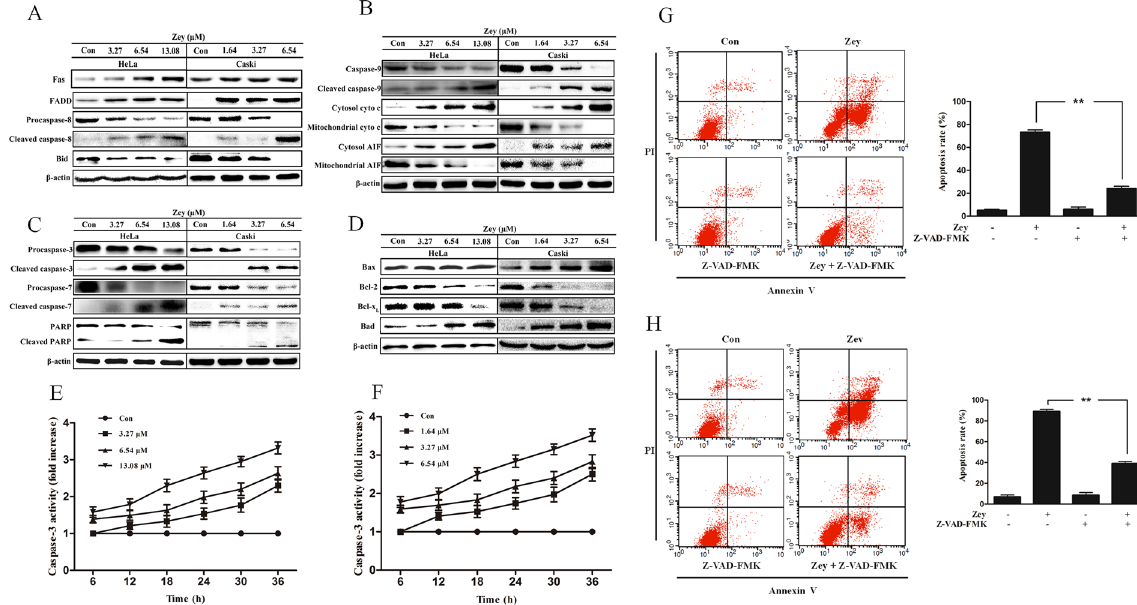
Figure 5. Zey induces apoptosis of HeLa and CaSki cells through caspase activation. ( A ) Zey induced expression changes of FAS, FADD, Bid, pro-caspase 8, and cleaved-caspase 8. ( B ) Zey induces release of AIF and cytochrome C from mitochondria and cleavage of caspase 9. HeLa and CaSki cells were treated with Zey for 24 h, then cell cytoplasm were extracted by digitonin buffer and the released AIF and cytochrome C were detected by western blot analysis. ( C ) Zey induces cleavage of PARP, caspases-3, and -7 in HeLa and CaSki cells. ( D ) Zey decreased expression of antiapoptotic proteins Bcl-XL, and Bcl-2, and increased expression of apoptotic proteins Bax and Bad. Zey inhibits caspase 3 activity of HeLa ( E ) and CaSki cells ( F ). Data were presented as the means ± SD for triplicate determinations. * P < 0.05, ** P < 0.01 versus control cells. Pan caspase inhibitor Z-VAD-FMK significantly attenuated Zey-induced apoptosis in HeLa ( G ) and CaSki cells ( H ). Data are presented as the means ± SD for triplicate determinations. ** P < 0.01 versus control